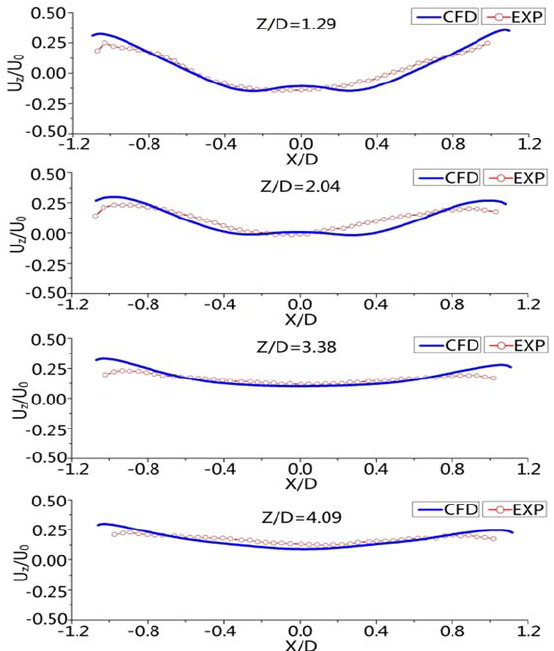
Figure 4. Compare of CFD and EXP results of velocity profile.